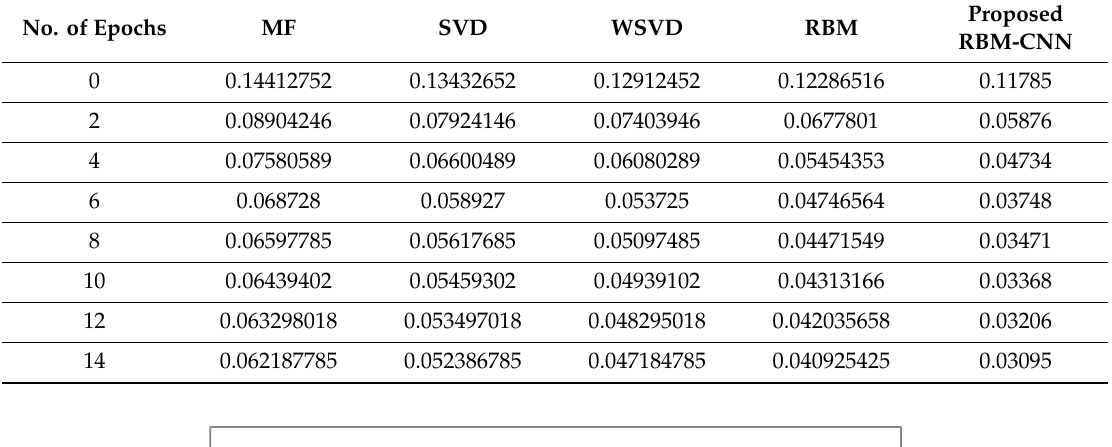
Table 3. Comparison among number of epochs and MAE of di ff erent methods.